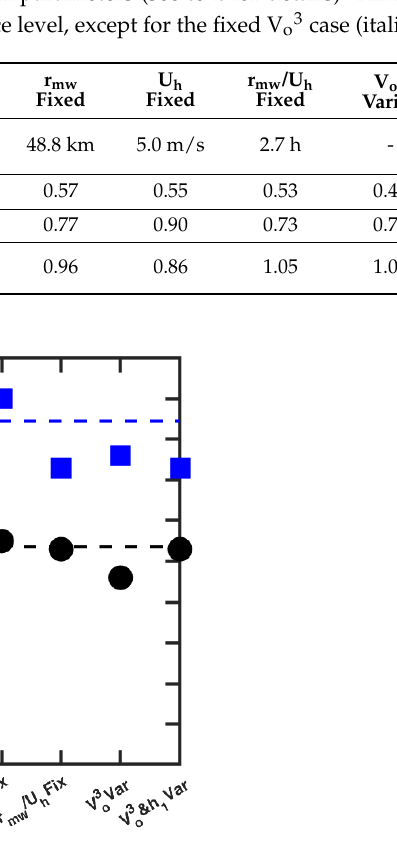
Figure 5. The explained variance r 2 (circles) and the slope “a” (squares) as a function of the physical parameters, either variable or fixed (the abscissa) (Table 1). Dashed lines show their mean values. Open symbols (for the fixed V o3 case: V o3 Fix) indicate insignificant values at the 99.9% confidence.